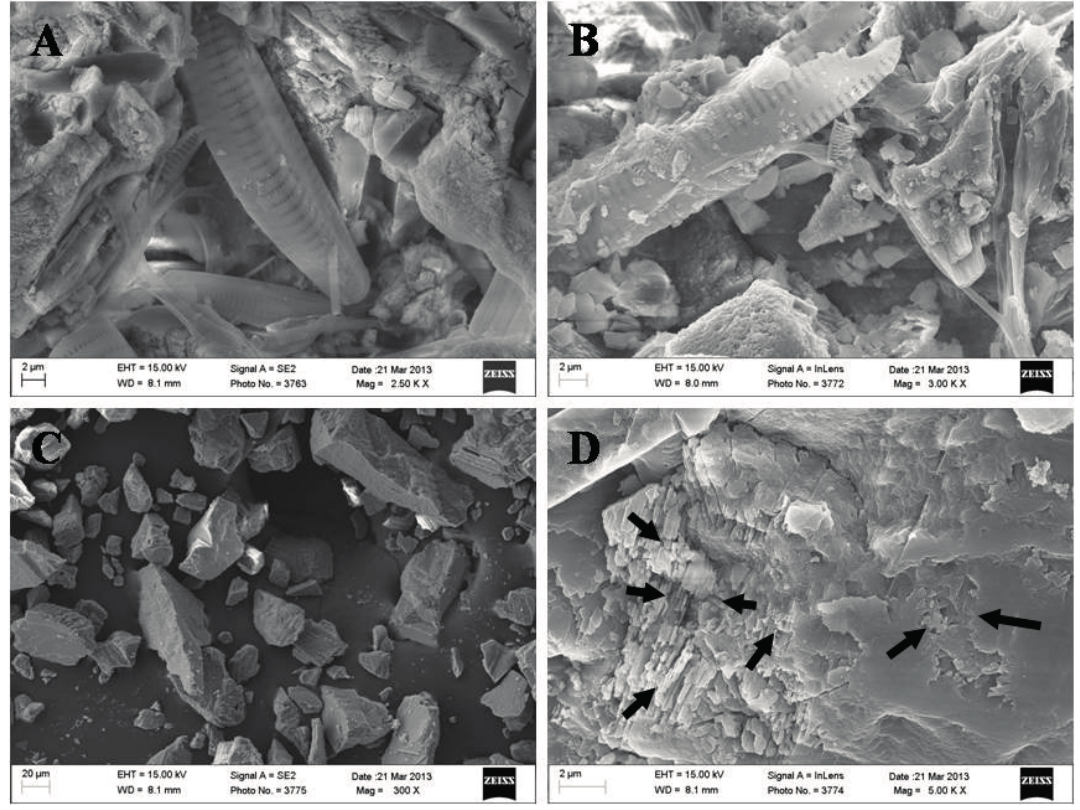
pretreated travertine sample and synthetic calcite. Figure 6. SEM micrographs of CO 2 Panels ( A ), ( B ) show microscopy pictures of sample collected at Jinshapudi shoal. Panels ( C ), ( D ) show microscopy pictures of reference sample of synthetic calcite. Arrows in panel (D) show etching effects on synthetic